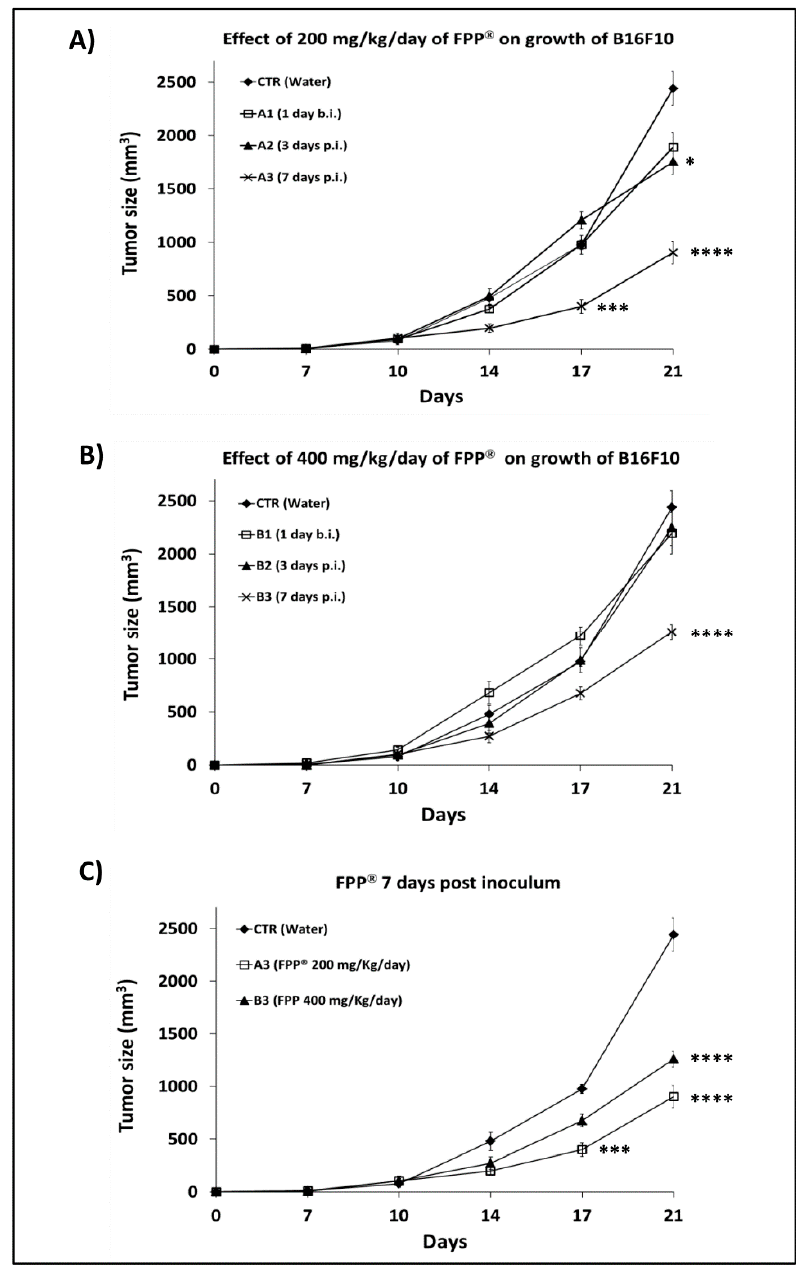
Figure 2. Effect of 200 mg/Kg/day and 400 mg/Kg/day of FPP ® through oral gavage on growth of B16F10 in C57/BL mice. Dose-response curve of FPP® on tumor growth (mm 3 ) in C57/BL mice treated by oral gavage with 200 mg/Kg (group A1, A2, A3) and 400 mg/Kg of FPP ® (groups B1, B2, B3) every day without interruption until animal sacrifice, after 21 days from the inoculum of B16F10 cells (300000). Mice were divided into seven groups of five animals (control, A1, A2, A3, B1, B2, B3) and were treated with FPP ® respectively 1 day before the inoculation of the cells (groups A1, B1), 3 (groups A2, B2) and 7 (groups A3, B3) days after the inoculation of the cells. Control group is the untreated group. ( A ) Effect of 200 mg/Kg/day of FPP ® on growth of B16F10 in C57/BL mice (groups A1, A2, A3) until animal sacrifice. ( B ) Effect of 400 mg/Kg/day of FPP ® on growth of B16F10 in C57/BL mice (groups B1, B2, B3) until animal sacrifice. ( C ) Effect of FPP ® treatment 7 days post inoculum of the cells on growth of B16F10 in C57/BL mice comparing treatment with 200 mg/Kg/day of FPP ® (group A3) and 400 mg/Kg/day of FPP ® (group B3). Data are expressed as means ± SE. * p < 0.05, *** p < 0.0005, **** p < 0.0001.